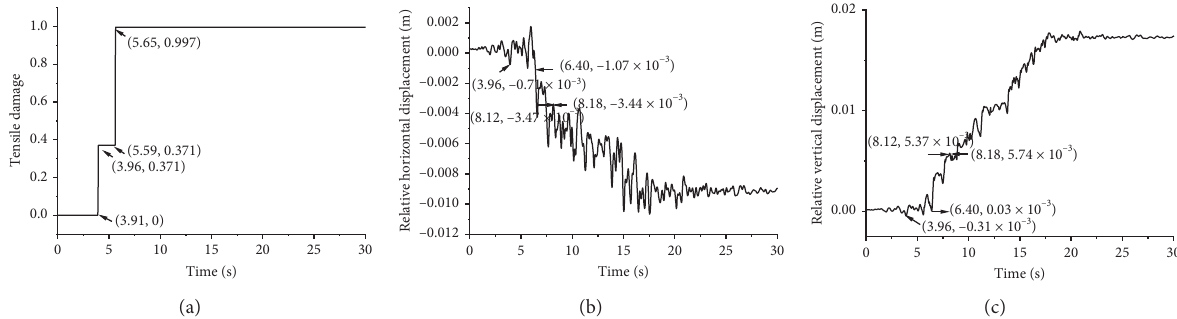
Figure 13: Time histories of relevant variables at the element 3143 for the earthquake overload coefficient of 2.0. (a) Time history of tensile damage variables. (b) The relative horizontal displacement is 8.97 mm after the earthquake. (c) The relative vertical displacement is 17.38mm after the earthquake.